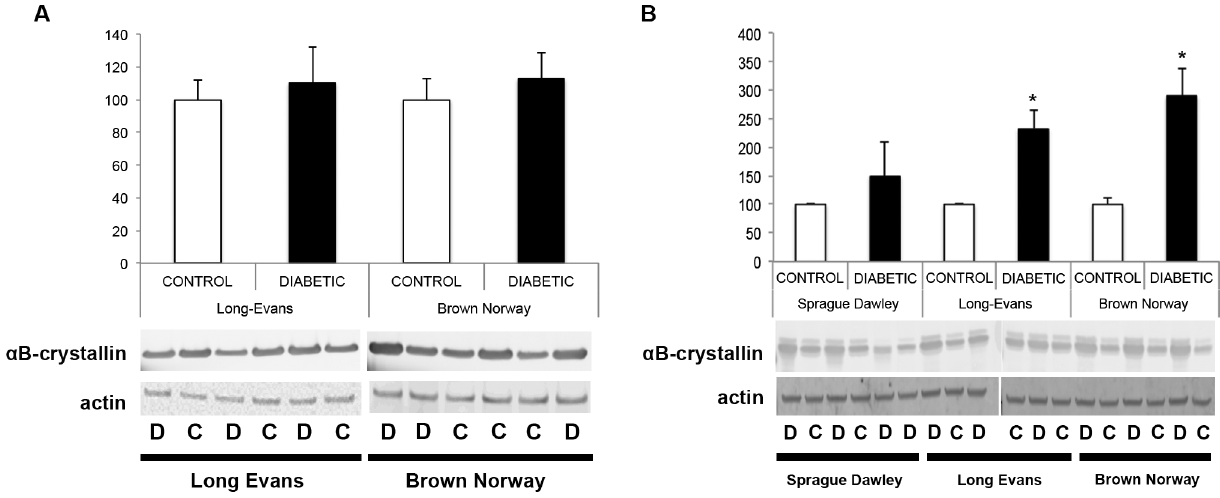
Figure 5. Protein expression analysis of alphaB-crystallin during diabetes. Expression levels were assessed with Western blot analysis using specific antibodies raised against alphaB-crystallin proteins 4 weeks after the onset of diabetes (A) in Long Evans (LE) and Brown Norway (BN) rats. Expression levels were also assessed at 12 weeks (B) in Sprague Dawley (SD), in Long Evans (LE) and Brown Norway (BN) rats. Representative immunoblots and graphic representation of the corresponding quantification of the major bands are presented. C, control; D, diabetic. *Significantly different from control [ P , 0.05].